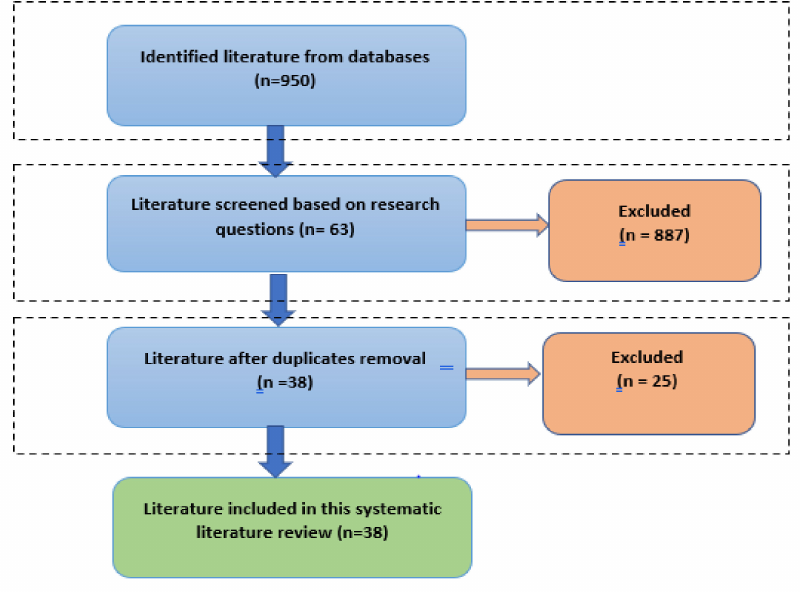
Figure 4. Flow diagram of the search.